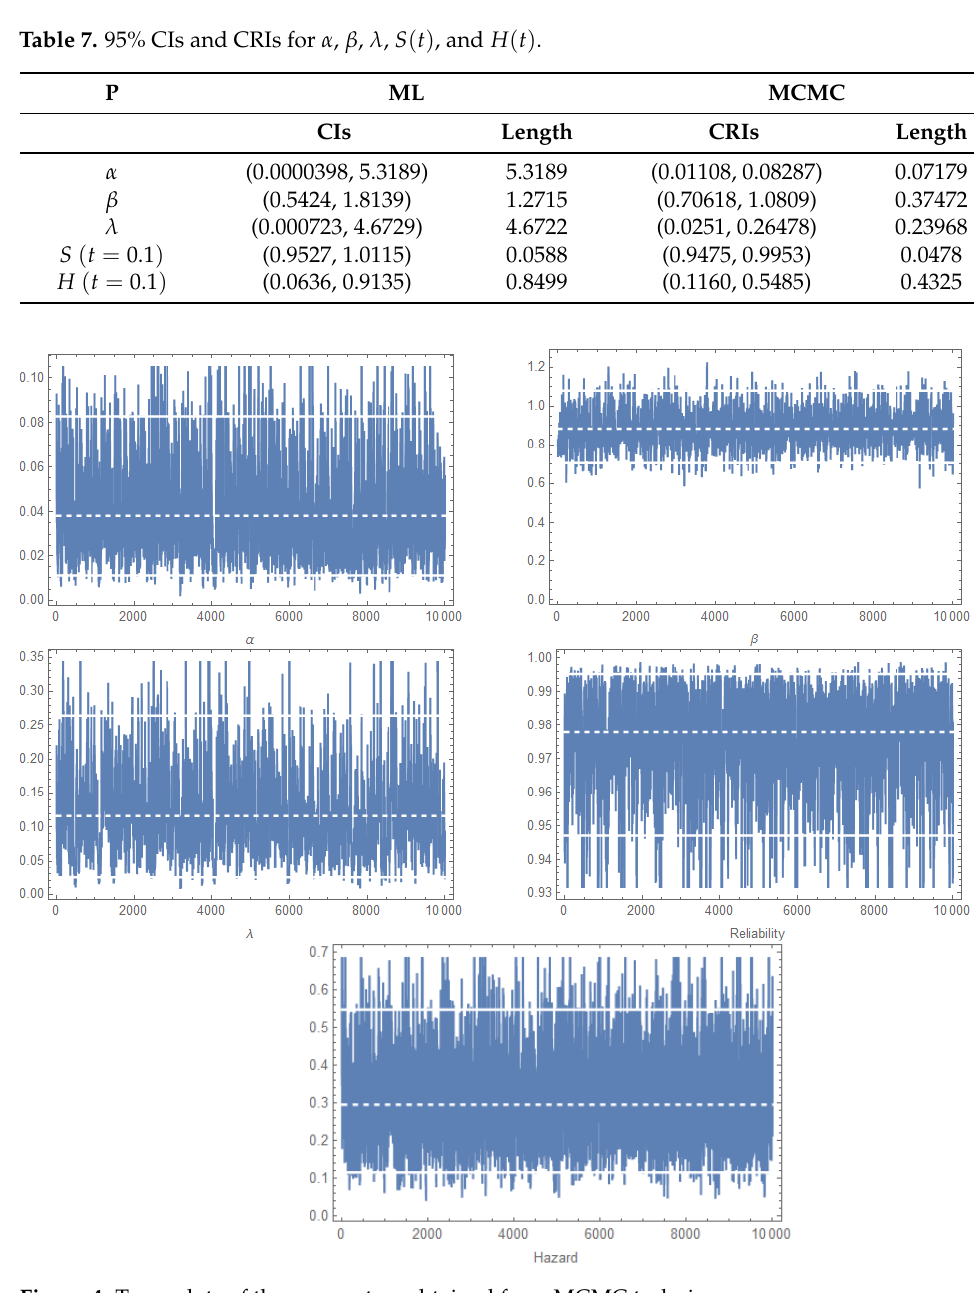
Figure 4. Trace plots of the parameters obtained from MCMC